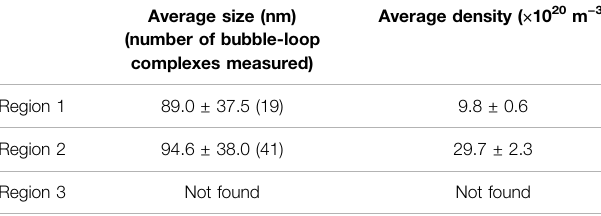
TABLE 3 | Summary of average size and density of bubble-loop complexes in different regions. Average size (nm) (number of bubble-loop complexes